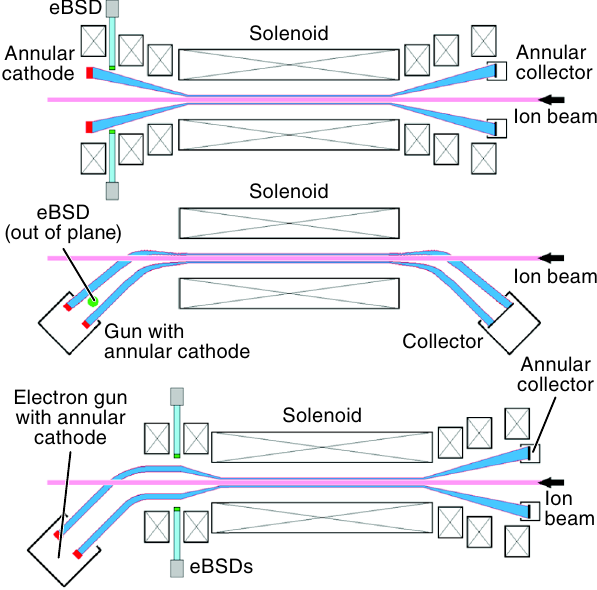
FIG. 21. Three possible configurations for using eBSDs for halo monitoring and beam alignment of hollow electron beam systems. The central long solenoid is the same strong field superconducting solenoid in each case, similar to the 6 T ones used in the Brookhaven RHIC electron lenses. The smaller and weaker room-temperature solenoids, indicated schematically by the small rectangles, guide the electron beam from the gun to the central solenoid and from there to the collector (see Fig. 3). Some of these guiding solenoids have been omitted for clarity. Only two eBSDs are shown in the bottom configuration, but there could be four at 90° intervals for continuous halo monitoring and beam centering. The bottom configuration seems to be the most feasible one (see text).